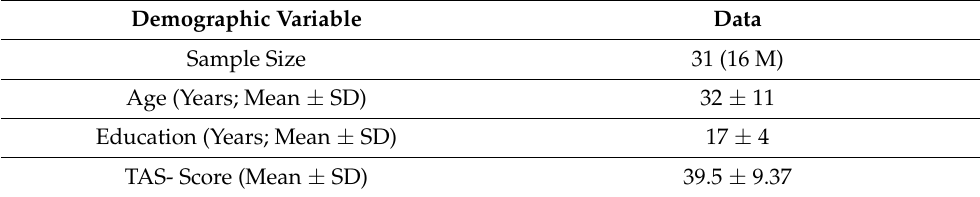
Table 1. Demographic data for each participant.